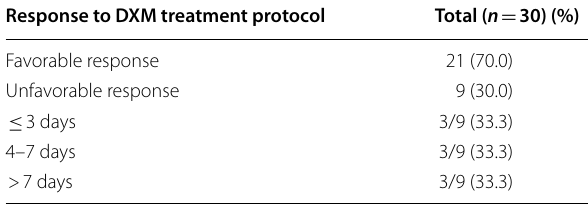
DXM dexamethasone, n number of patients